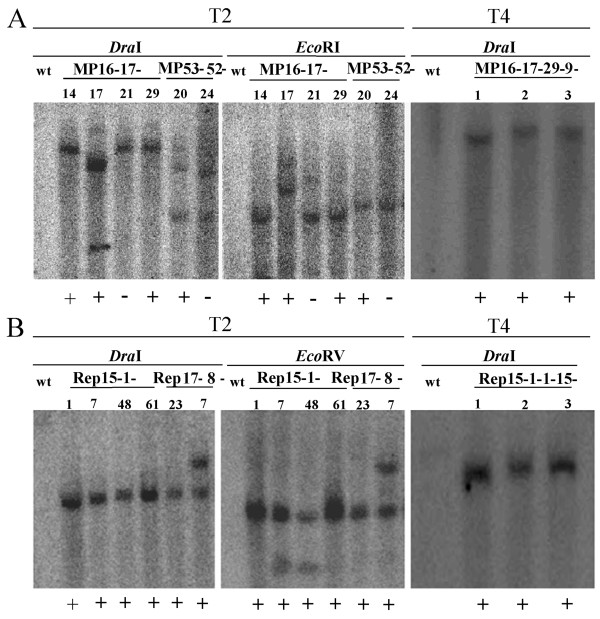
Southern blot analyses of T2 and T4 transgenic plants expressing hairpin RNA of TMV partial MP (A) or CMV partial Rep (B). Genomic DNA from immune (+), susceptible (-) or wild type tobacco (wt) plants was digested with DraI, EcoRI or EcoRV, and hybridized with a radioactively labeled TMVΔMP (A) or CMVΔRep (B) probe.